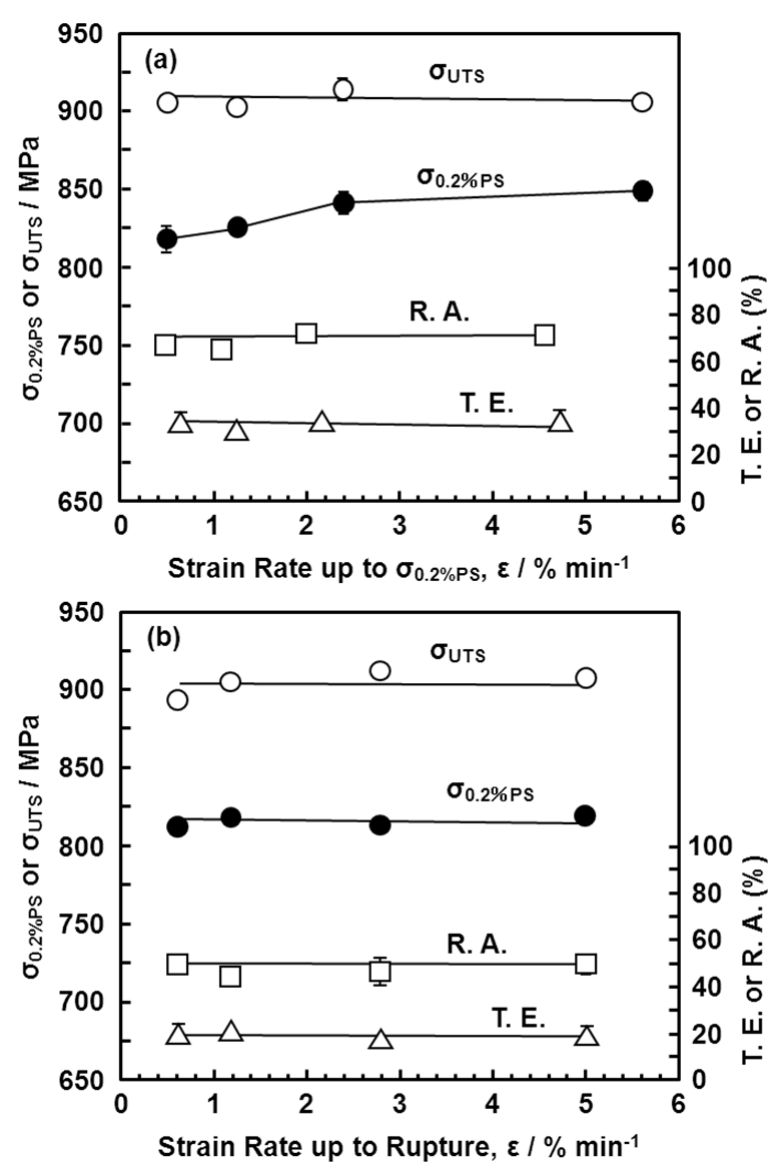
Figure 11. Effects of strain rate (%/mm) on room-temperature mechanical properties ( σ , σ , total elongation (T.E.) and reduction in area (R.A.)). ( a ) Effect of strain rate 0.2%PS UTS up to σ ; ( b ) effect of strain rate from σ 0.2%PS